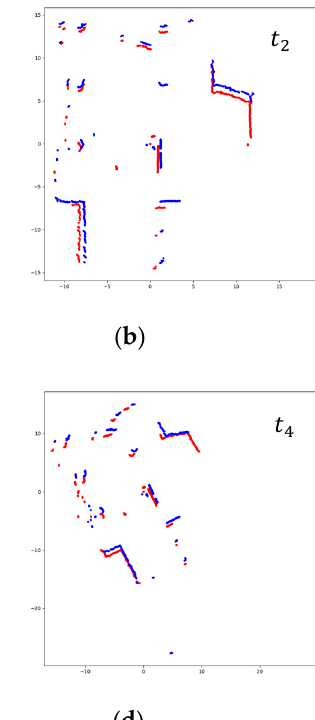
( a ) ( b ) Figure 8. Classification of scan matching images after preprocessing (Red: previous scan, blue: cur- rent scan). ( a ) Normal; ( b ) fault.